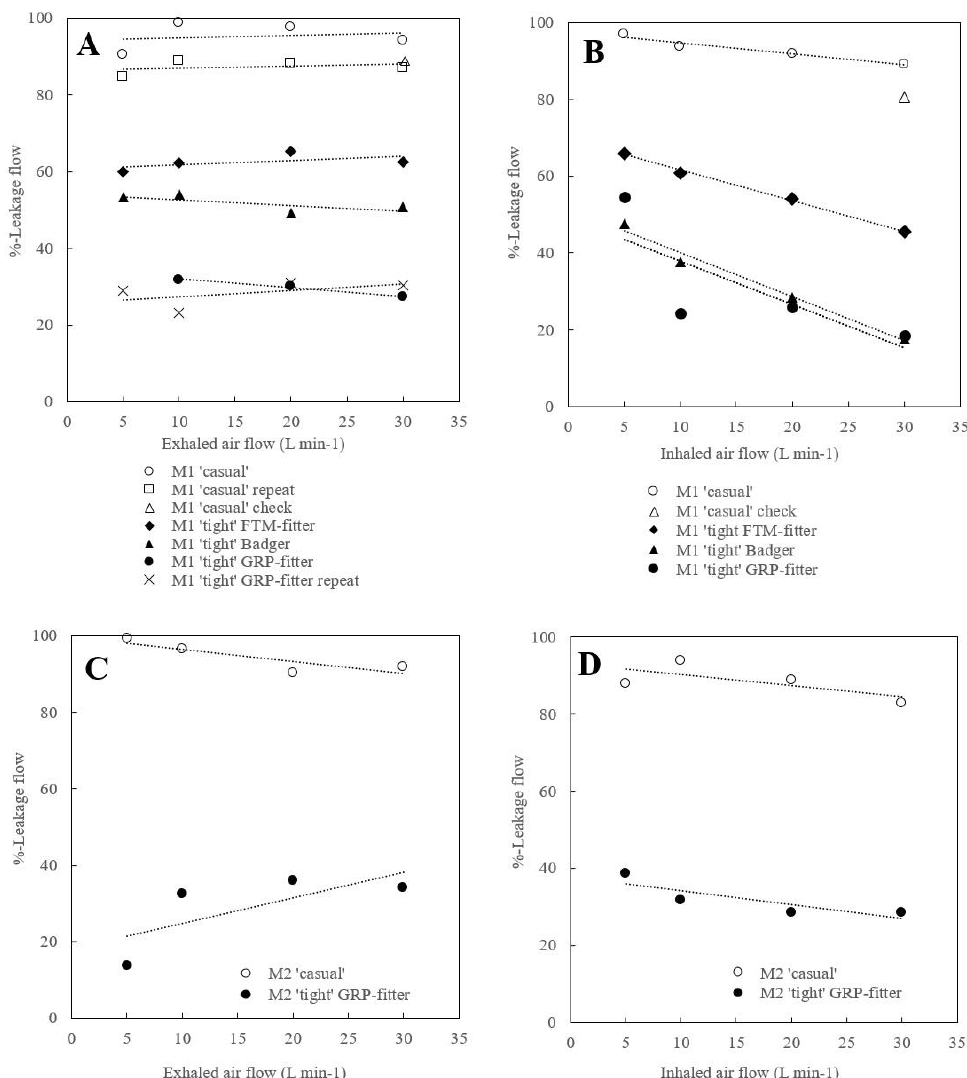
Figure 3. Percent of leakage flow Q leak / Q versus simulated steady respiration at exhalation ( A , C ) and inhalation ( B , D ) for masks M1 ( A , B ) and M2 ( C , D ) in ‘casual’ and ‘tight’ mounting by fitters, respectively. Trends are illustrated by the linear regression lines.